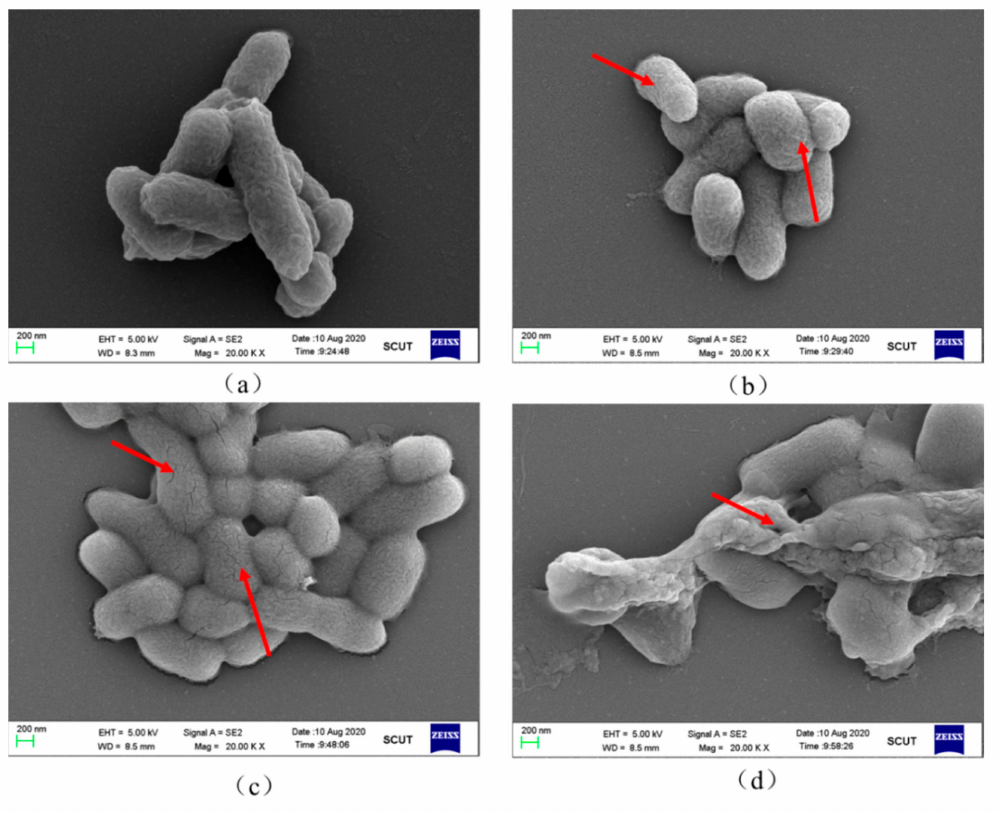
Figure 7. Effect of cold plasma treatment on the morphology of S. typhimurium. ( a ) Control; ( b ) DBD- treated for 1 min; ( c ) DBD-treated for 3 min; ( d ) DBD-treated for 5 min. Red rows indicate the modifications in cell morphology and cell